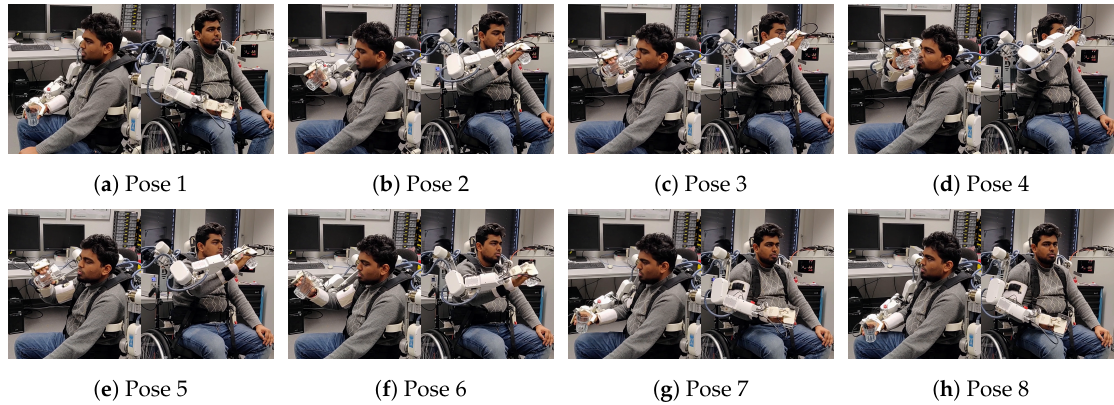
Figure 16. Teach and Replay mode with human subject for drinking